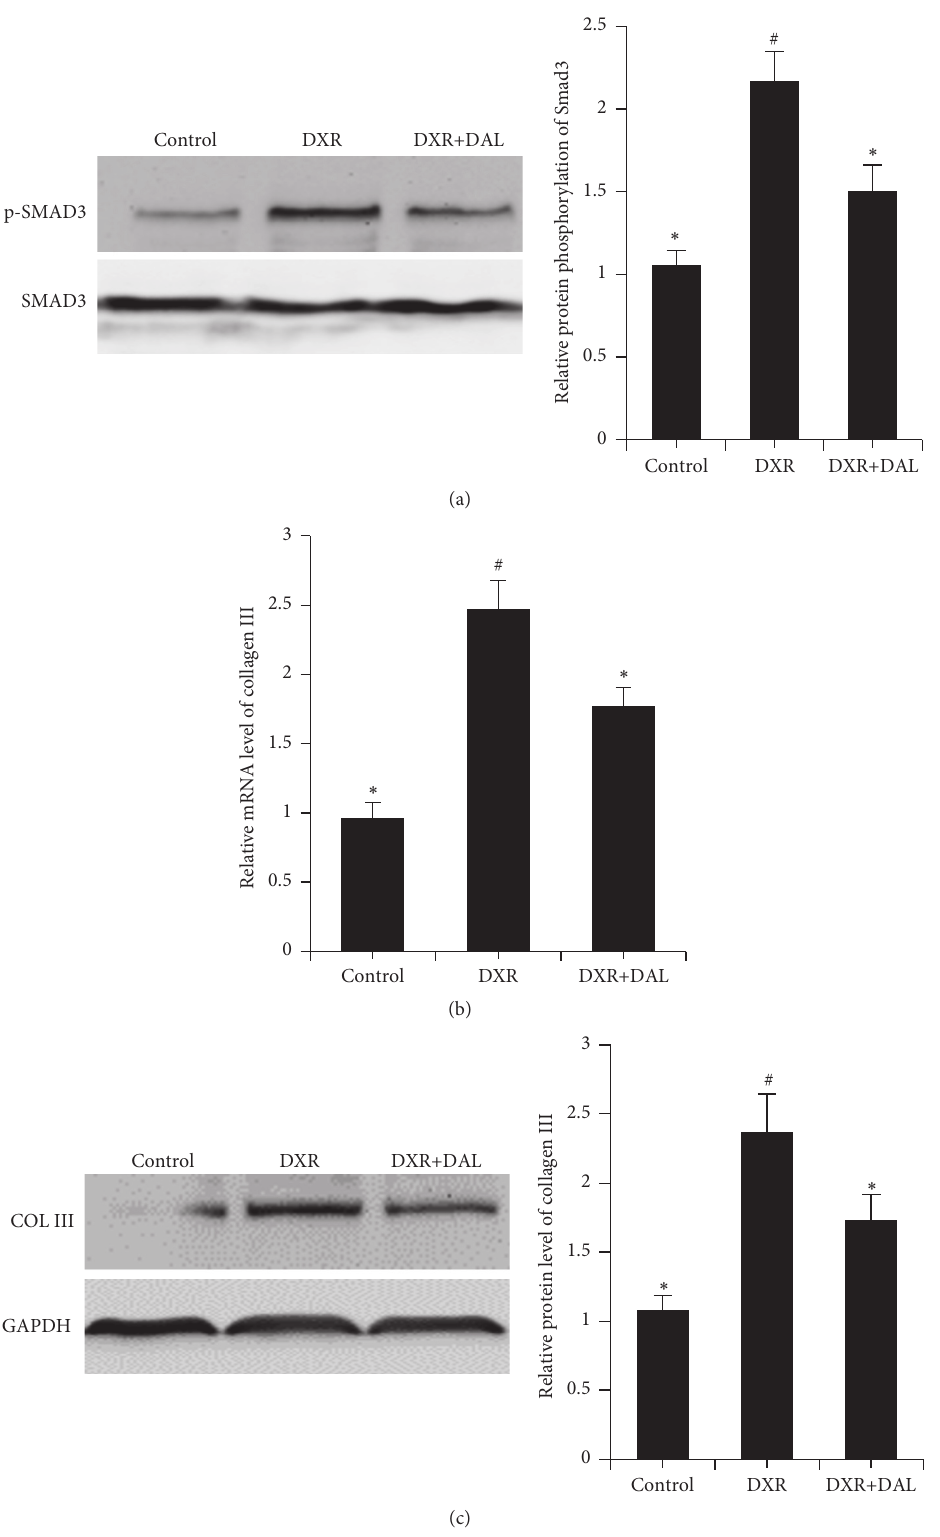
Figure 4: The TGF- 𝛽 signaling pathway in kidney tissue 5 weeks after DXR injection in different groups of mice as indicated. (a) DAL inhibits the phosphorylation of Smad3; (b) DAL inhibits the gene expression of collagen III, which is the target gene of Smad3; (c) DAL inhibits the protein expression of collagen III, which is the target protein expression of Smad3. The control and DAL treatment groups are compared with the DXR group. Values are statistically significant at ∗ 𝑝 < 0.05 ; the DXR group is compared with the control group. Values are statistically significant at # 𝑝 < 0.05